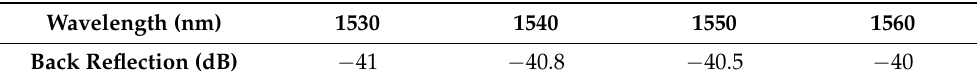
Figure 8. Back reflection calculation using FDTD simulations. Table 3. Back reflection loss values for the operating wavelengths.